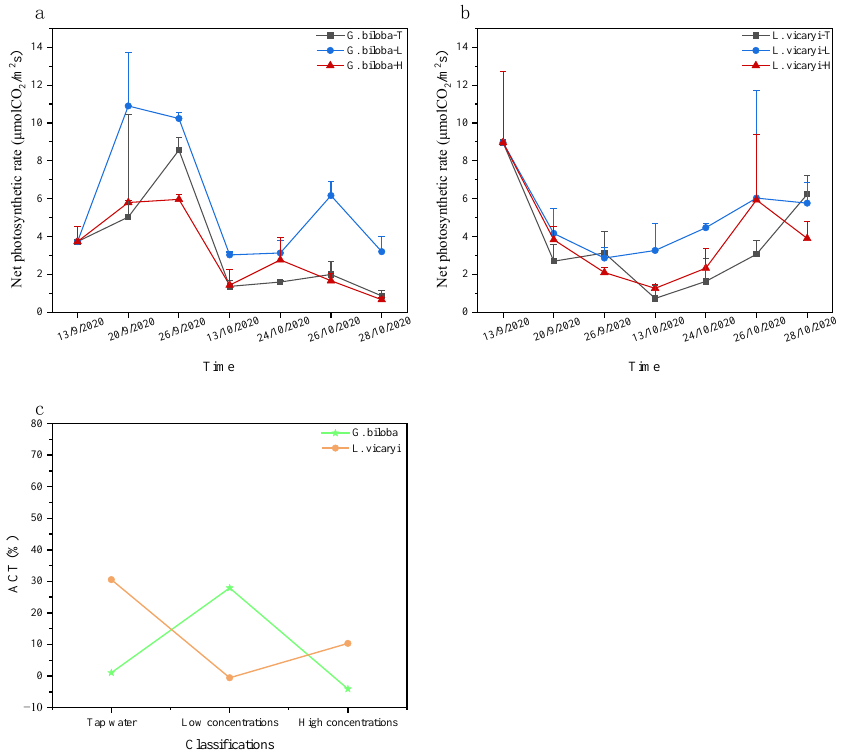
Figure 5. Changes in the ( a ) Ginkgo biloba L. and ( b ) Ligustrum × vicaryi net photosynthetic rates, error bar represented the measurement error of n leaf physiological index of the same plant, n = 3; and ( c ) ACT for the net photosynthetic rate.